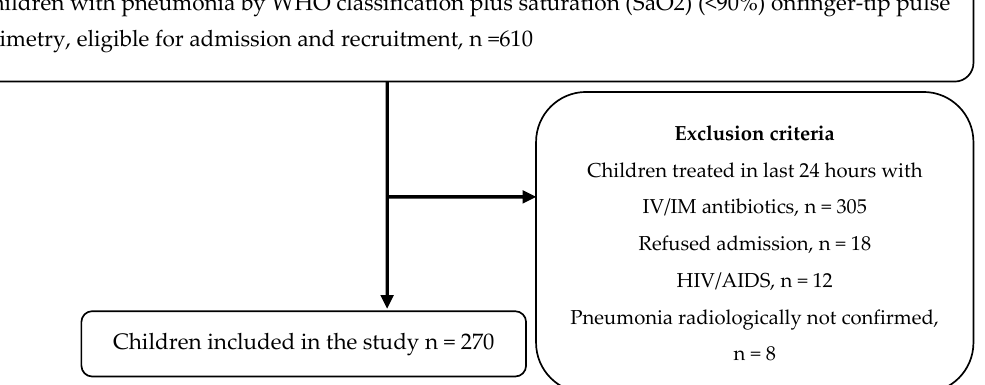
Children diagnosed with pneumonia, by WHO classification, n =6712